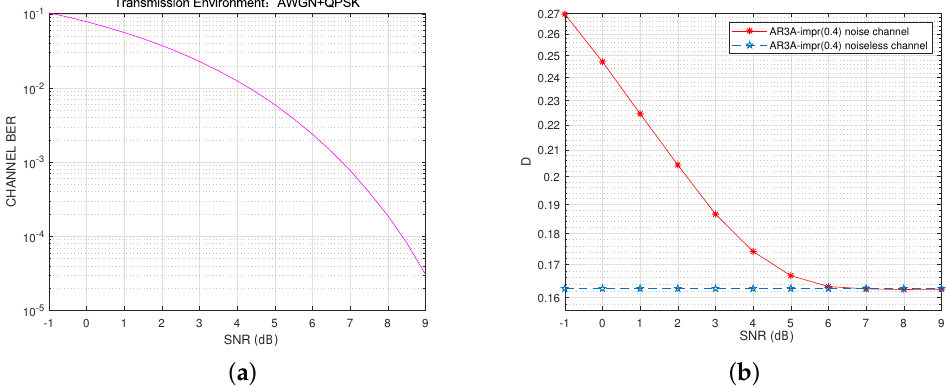
Figure 4. Index transmission environment and compression performance of AR3A-impr codes [11] over noisy channels. ( a ) QPSK modulation over AWGN channels ( b ) Code rate: 0.4 (RBP: 0.94 1.8).